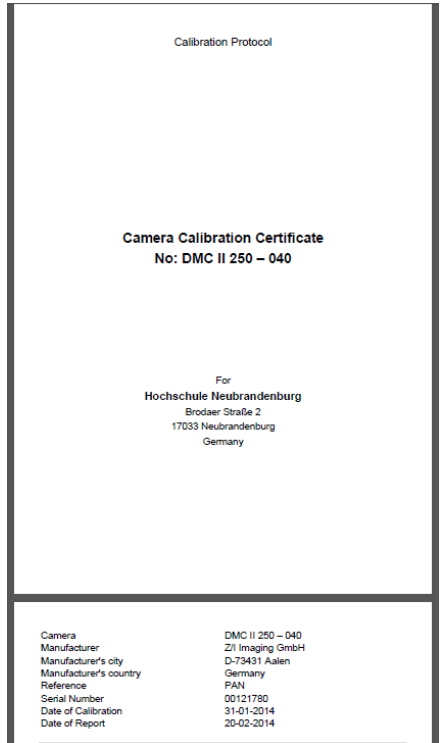
Figure 4. Example for a calibration report